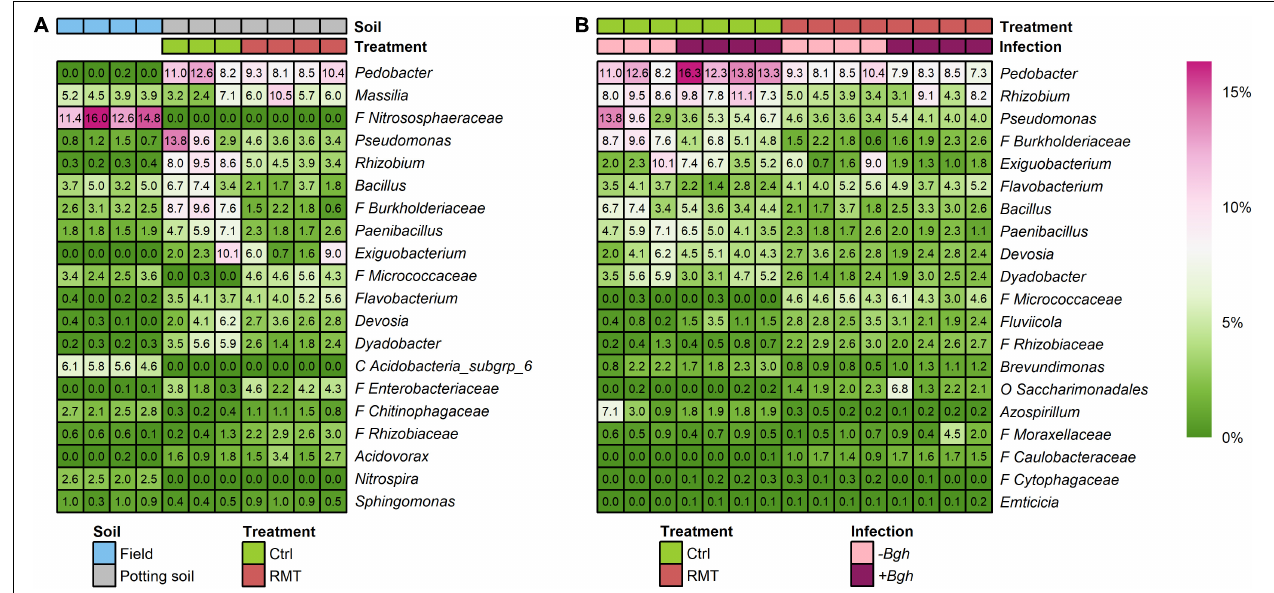
FIGURE 6 | Relative abundances of taxa. (A) Abundant taxa present in the rhizosphere of barley grown in field soil representing the rhizosphere microbiome transplant (RMT), rhizosphere of RMT-treated and control (Ctrl) plants grown in potting soil with reduced microbial diversity. (B) Abundant taxa differing between Ctrl and RMT rhizospheres as determined with a likelihood ratio test under negative binomial distribution and generalized linear models (FDR-corrected; p ≤ 0.05). Additionally, relative abundances of Fluviicola , Emticicia, and Cytophagaceae were differing due to Bgh challenge in Ctrl samples. F, family; O, order; C,